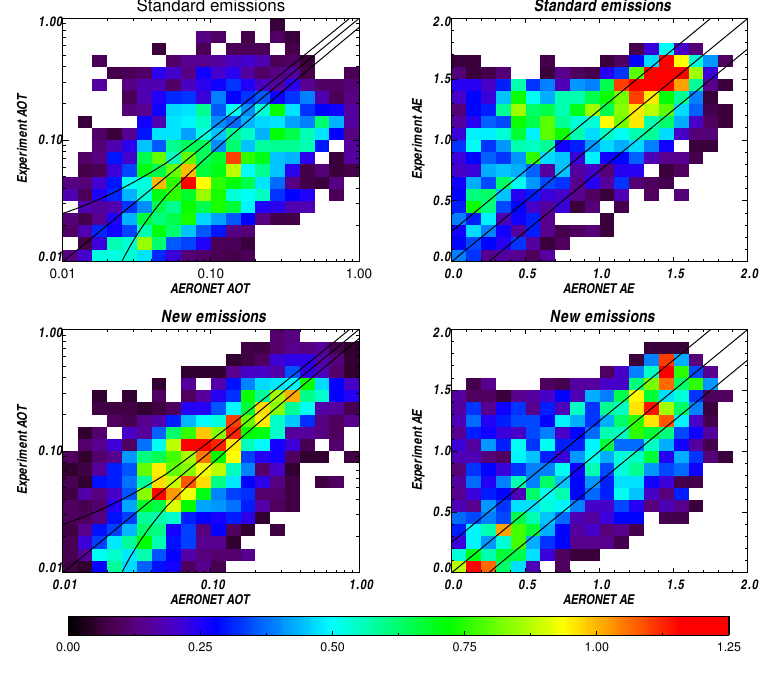
Figure 5. Distribution of 3-hourly co-located experiment and AERONET AOT and AE for the last three weeks of January 2009. The central black line represents y = x and the outer two black lines represent maximum AOT and typical AE errors. The colour bar shows percentage of total